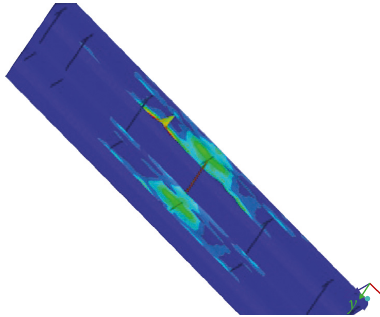
Figure 14: Stress distribution of damage state.